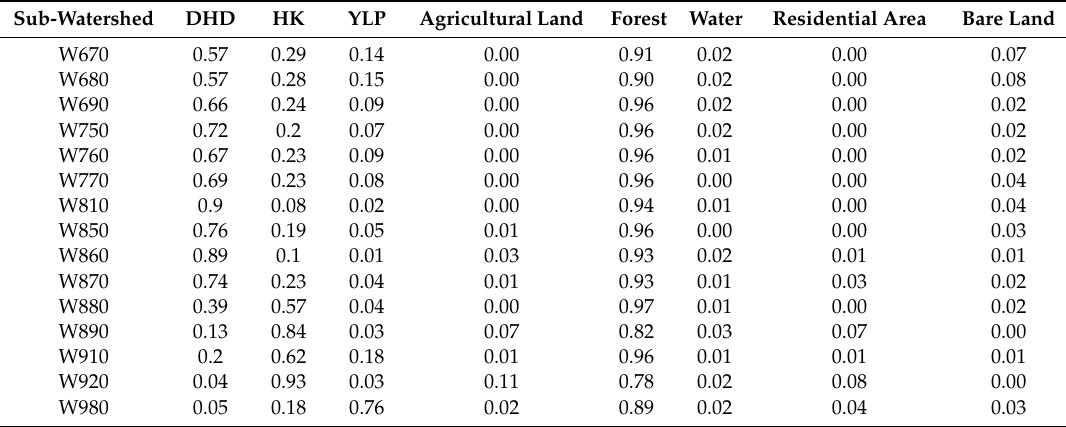
Table 4. The weights of three rainfall stations and the proportion of land use for each